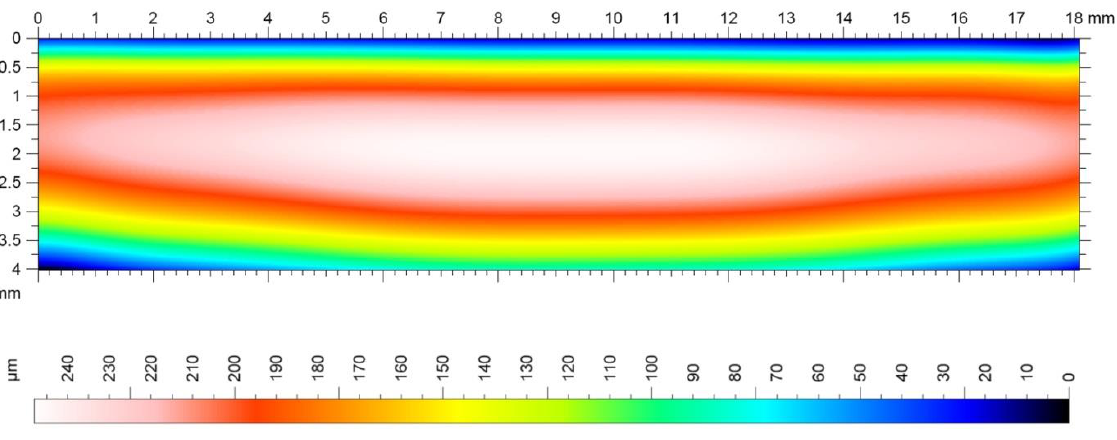
Figure 14. Topography of the machined surface of a gear with a longitudinal modification of the outline, m = 4.5 mm, e = 0.16 mm.